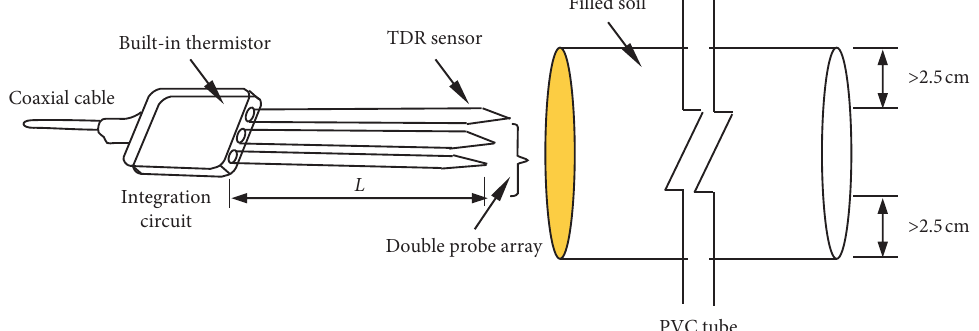
Figure 2: Schematic diagram of the TDR sensor and the calibration test device.